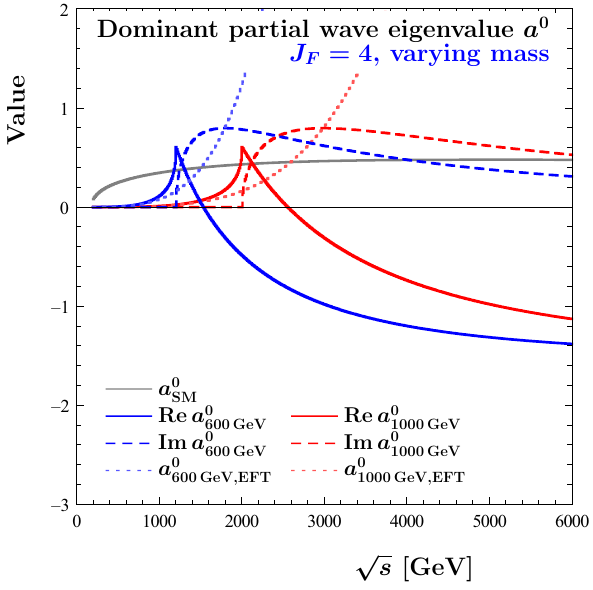
, two different masses of the extra particles, 600 GeV (blue curves) and √ J R 1000 GeV (red curves). Solid lines represent the real part of a 0 , long s . Results are dashed lines the imaginary part, and the short dashed lines give the purely real partial wave amplitudes in the EFT approximation. The SM contribution, at tree level, is shown for